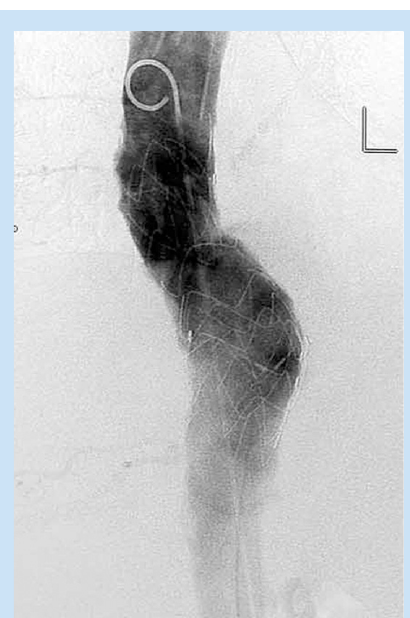
Fig. 1b. Post-procedural image after stent graft